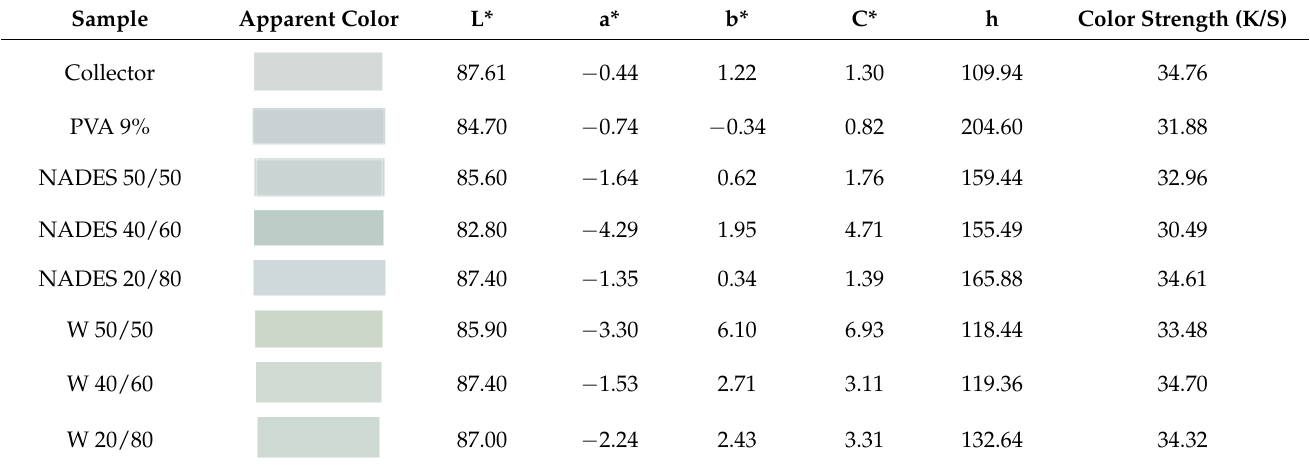
Table 4. Color analysis of nanofibers.